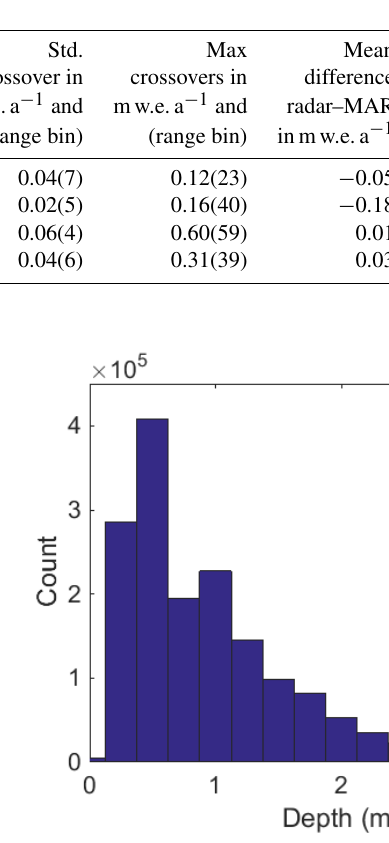
Figure 7. Histogram of first layer depth from 2009 through 2012 showing that the majority 63% of the first layer depths are within the top 1m of